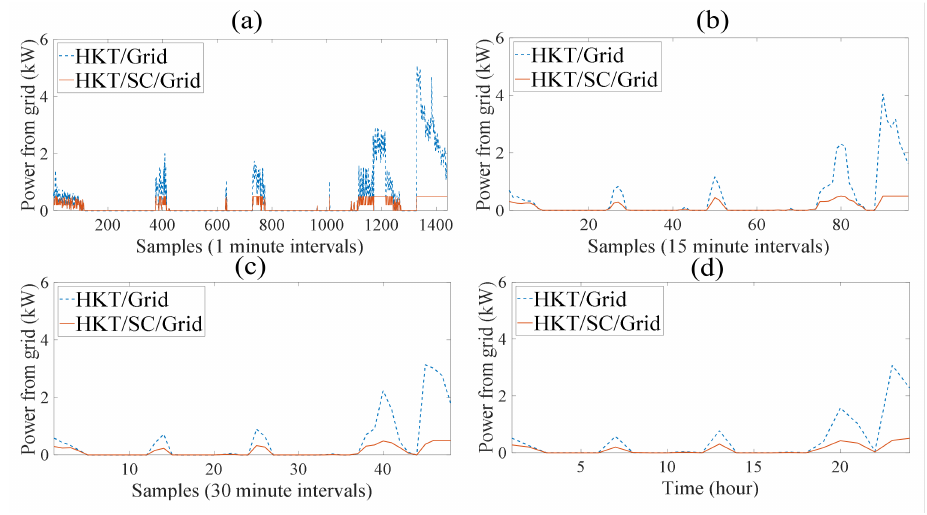
Figure 9. Electric power from the utility grid in case of unmet load by HKT. Data sampling at different time intervals: ( a ) 1 min, ( b ) 15 min, ( c ) 30 min and ( d ) every hour.